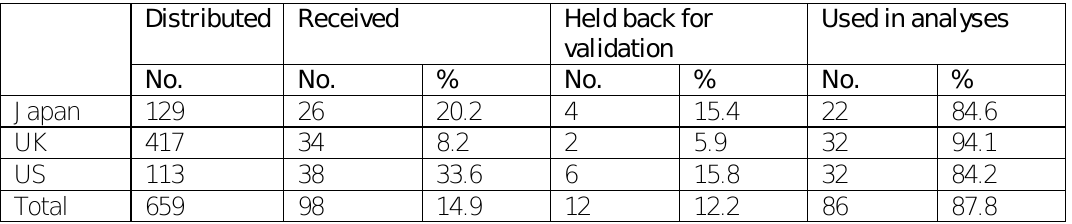
Table 1: Questionnaire survey